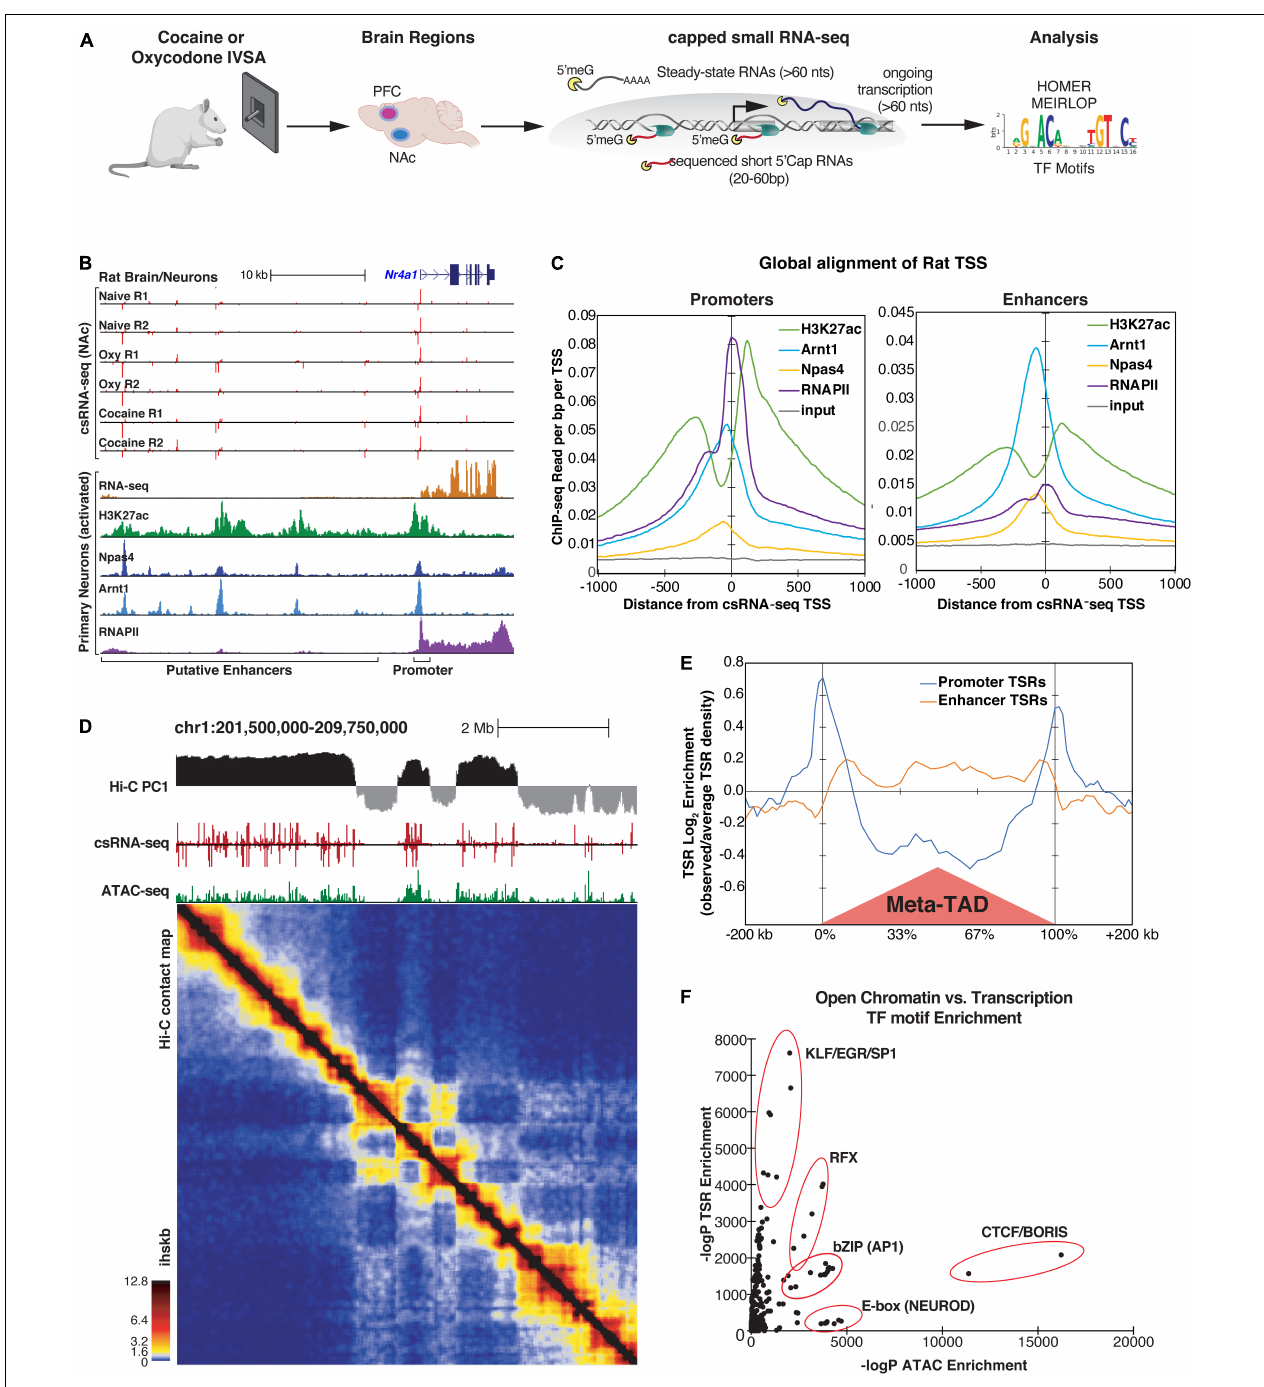
FIGURE 1 | Identification of Transcriptional Start Regions (TSRs) by csRNA-seq in rat brain tissues. (A) Diagram of study design. (B) An example of csRNA-seq data generated from naive, cocaine-, and oxycodone-exposed rat brains at the Nr4a1 locus (top) showing overlap with previously published transcriptomic and epi-genomic data from rat hippocampal neurons (bottom). (C) Distribution of various histone marks and TFs from primary rat hippocampus neurons with respect to promoter-associated (left) or enhancer-associated (right) TSRs identified by csRNA-seq in rat brains. Regions are aligned to the primary transcription start site (TSS) in the TSR. (D) Genome browser tracks from a representative region of chr1 showing (from top to bottom) A/B chromatin compartments (PC1 from Hi-C), TSRs (csRNA-seq), open chromatin regions (ATAC-seq), and the corresponding contact map of chromatin interactions (Hi-C) from rat PFC tissues. Ihskb = interactions per hundred square kilobases per billion mapped reads. (E) Histogram showing the relative distribution of promoter and enhancer-associated TSRs around TAD regions identified by Hi-C. (F) Relationship between ATAC and csRNA motif enrichment for known TF motifs. Motifs recognized by key TFs sharing common DNA binding domains are